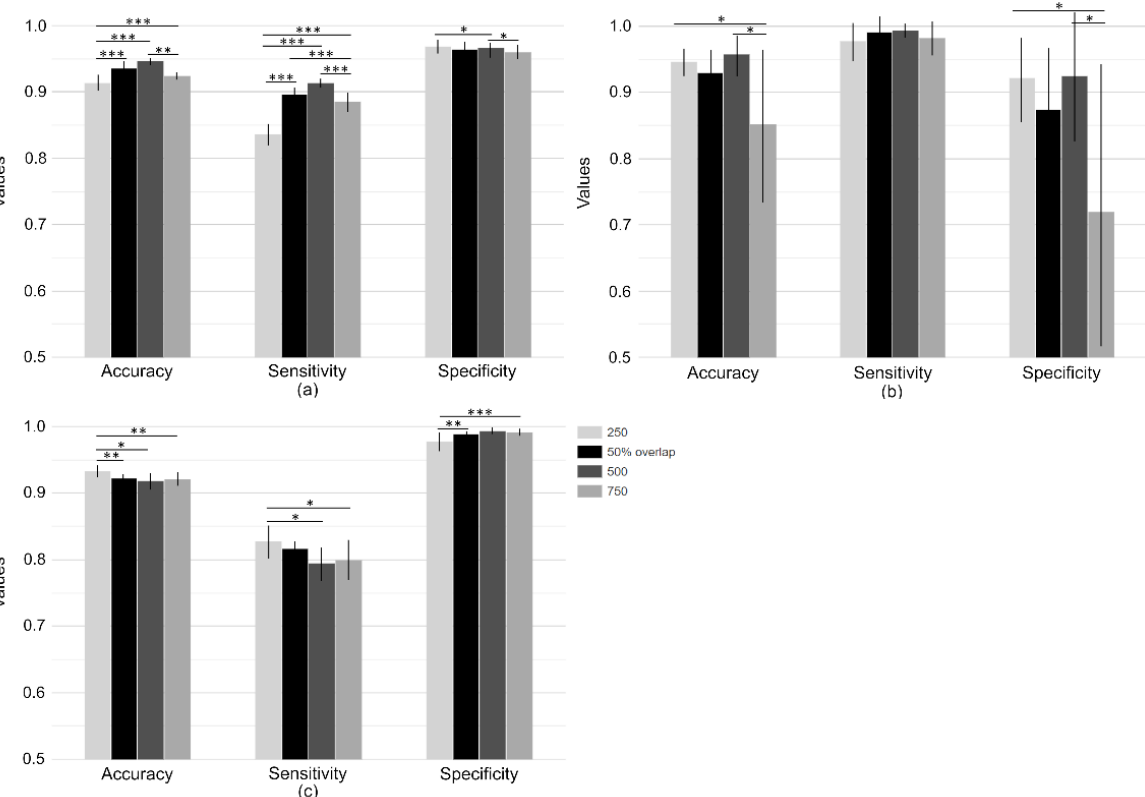
Figure 3. SVM classifier performance metrics across different epoch window lengths. ( a ) Classification of the SisFall test set. ( b ) Classification of the FARSEEING test set. ( c ) Classification of the elder participant in the SisFall dataset performing intentional falls. All window lengths of the non-overlapping approach are compared to one another as well as the 50% overlap approach with window lengths 250 and 750. Light gray, gray, dark gray, and black bars correspond to dataset lengths of 1.25 s, 2.5 s, 3.25 s all with the non-overlapping approach and 50% overlap with lengths of 500, respectively (* p < 0.05, ** p < 0.01, *** p < 0.001).